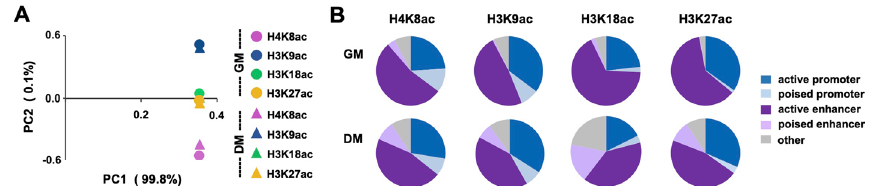
Fig. 4 Chromatin state associated with residue-specific histone acetylation. A C2C12 myoblasts were differentiated for 24 h (DM) and subjected to ChIP-seq with proliferating myoblasts (GM) as control. Shown is the PCA plot for the indicated histone acetylation read signals. B The distribution of H4K8ac, H3K9ac, H3K18ac, and H3K27ac read signals to distinct chromatin